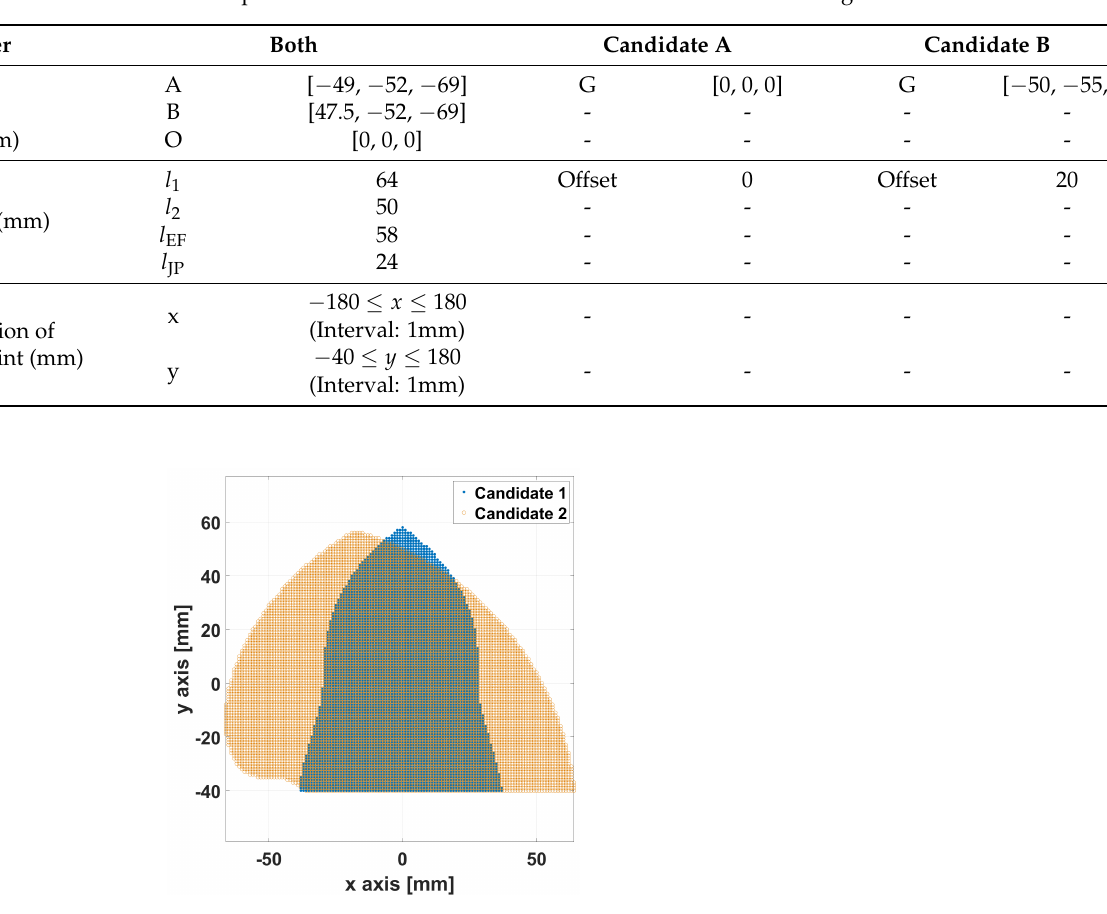
Figure 11. The derived reachable workspace for each candidate.